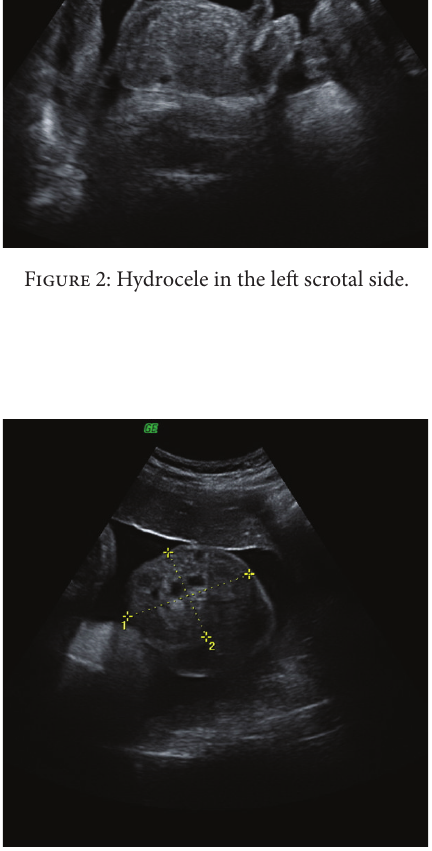
Figure 3: A week later: no modification in size of the mass; an increasing number of echo-free cystic areas.